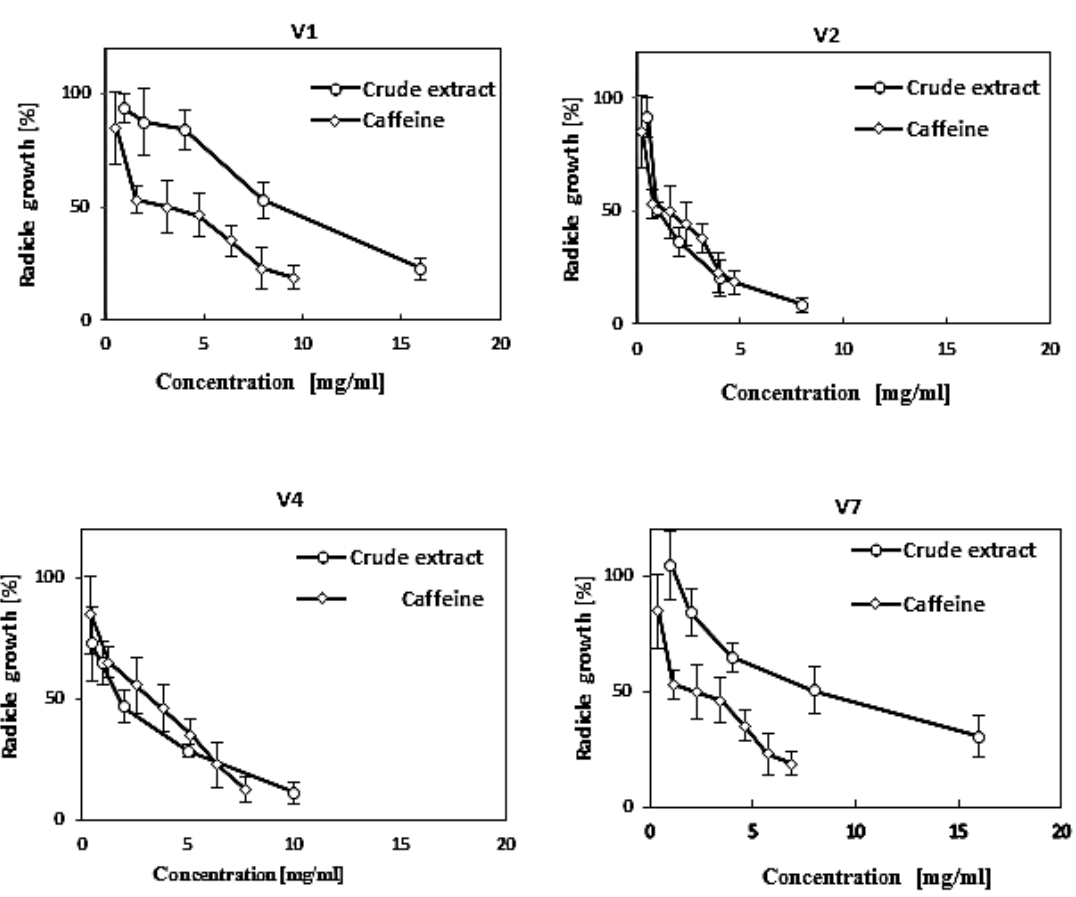
Figure 1. Inhibition activity of the radicle growth of lettuce seedlings caused by the crude extract of tea and by caffeine estimated to be present in crude tea extract. The data are the mean of three replications ± SD.